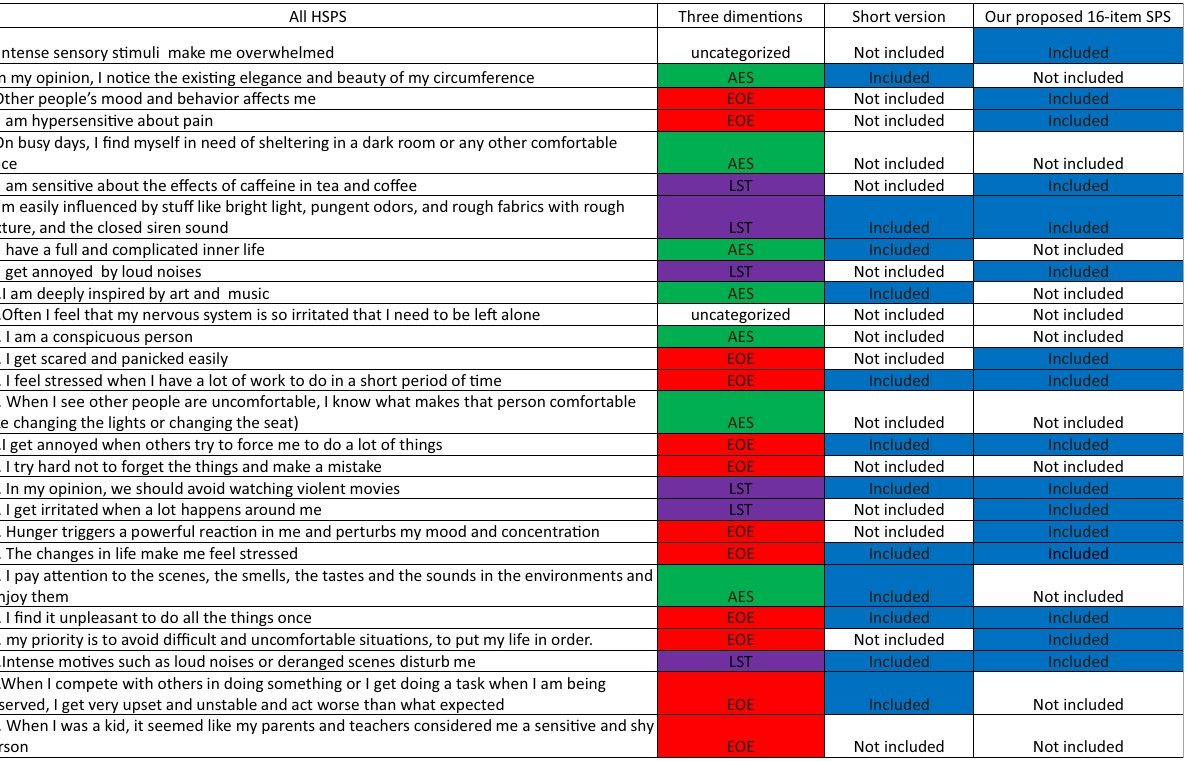
Table 1. 27-item HSPS questionnaire, its subdomains and its modified versions. The original back- translated 27-questions HSPS (1st left column) along with the designation of the three subdomains AES, EOE and LST (25 questions) with 2 questions being uncategorized (2nd column). Short version of HSPS is shown in the 3rd column and our modified 16 questions version in the 4th